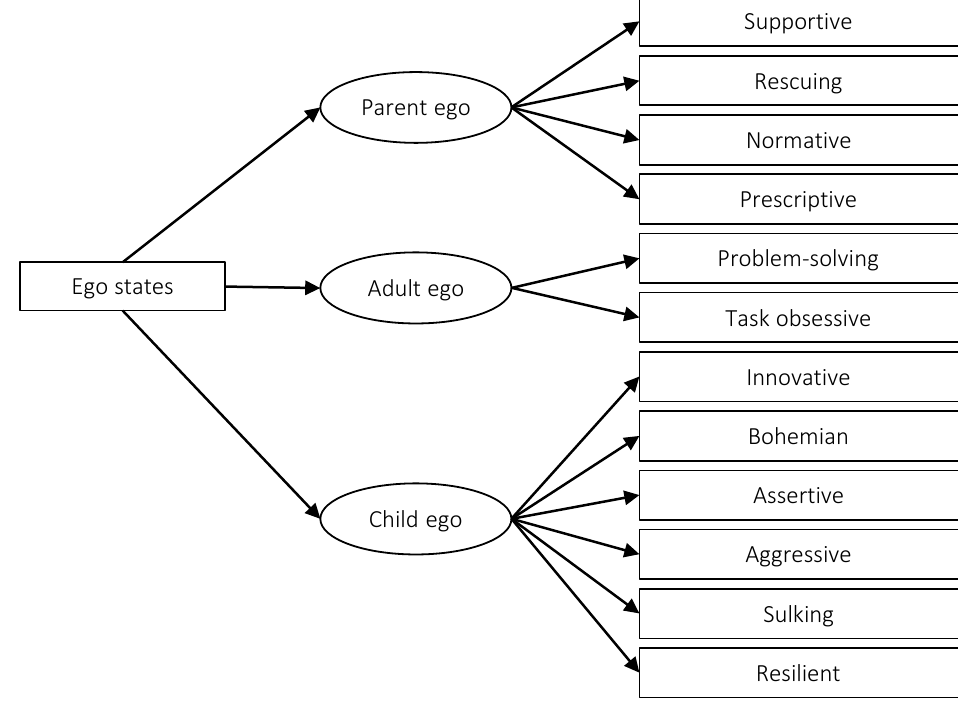
Figure 1. Theoretical framework